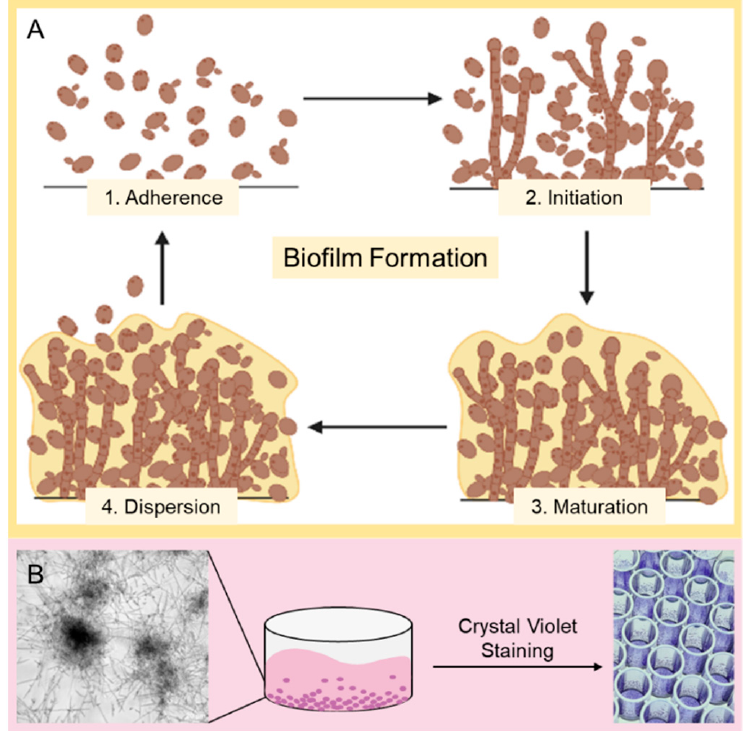
Figure 1. Candida biofilm formation, its typical appearance in microscopy and classic staining techniques. ( A ) Schematic overview of Candida biofilm formation. At first, (1. Adherence) planktonic yeast cells attach to the surface; after that (2. Initiation), the cells aggregate and proliferate until (3. Maturation) they form a mature biofilm with an extracellular matrix (ECM). In order to produce further biofilms, cells can detach themselves from the mature biofilm and find their way back into the planktonic phase (4. Dispersion). ( B ) Schematic representation of the experimental procedure. The efficiency of peptides on the biofilm (microscopy image with transmission light using a Leica Dmi8 (Leica Microsystems CMS GmbH, Wetzlar, Germany) in the lower left corner) of clinical Candida isolates was investigated using a microtiter dilution assay. During the incubation period, the Candida biofilm can form to different degrees depending on the potency of the peptides. After the incubation period, a crystal violet assay was performed to determine the biofilm mass. For this purpose, the biofilms were stained with crystal violet and then dissolved in 30% acetic acid to determine the biomass using a photometric measurement at 560 nm using a Tecan Infinite F200 microplate reader.